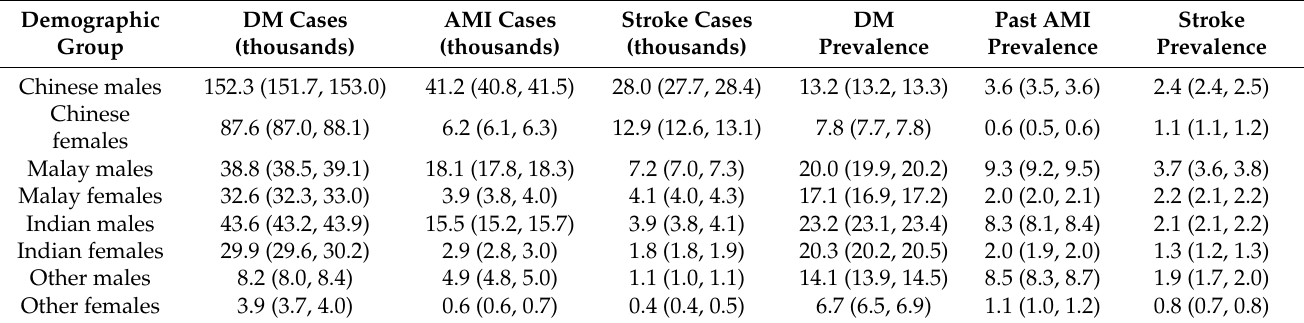
Table 1. Estimated case numbers and prevalence of Diabetes Mellitus (DM), past acute myocardial infarction (AMI) and stroke for those aged 18–69 in 2020 stratified by ethnicity and gender. Brackets indicate the 95% confidence intervals over 100 iterations.